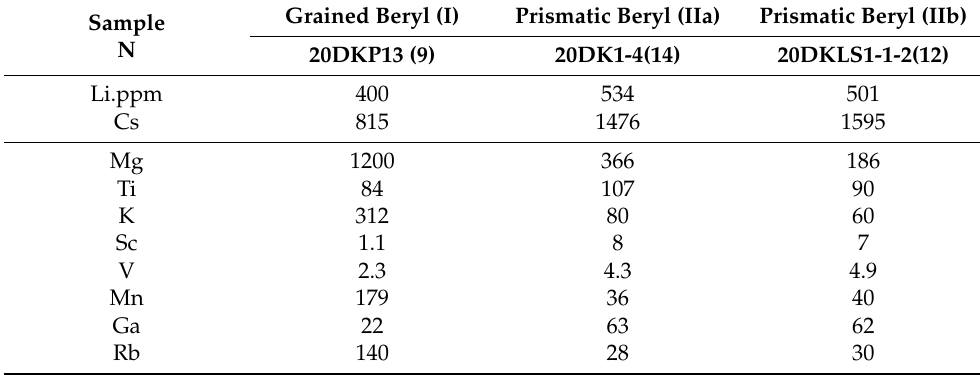
Table 2. The LA-ICP-MS trace element compositions of beryl in the Dakalasu No.1